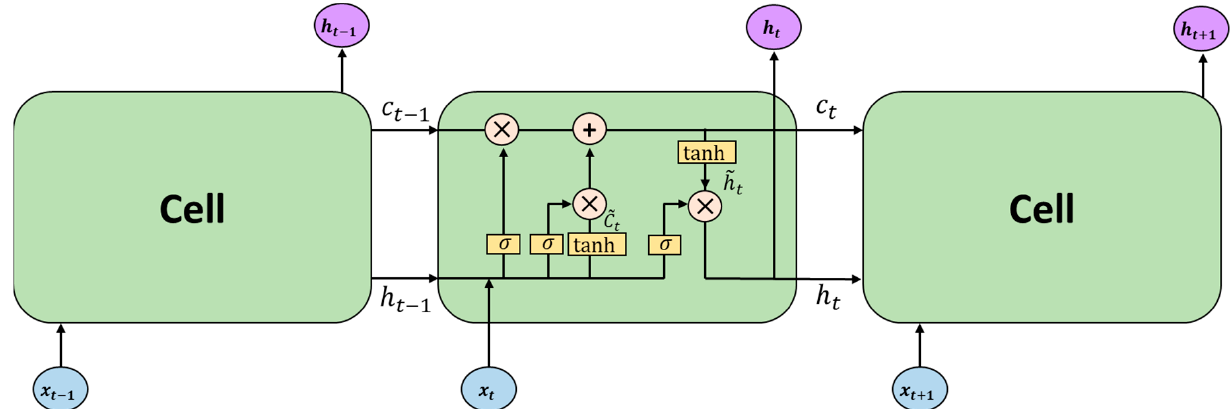
Figure 2. LSTM Architecture.